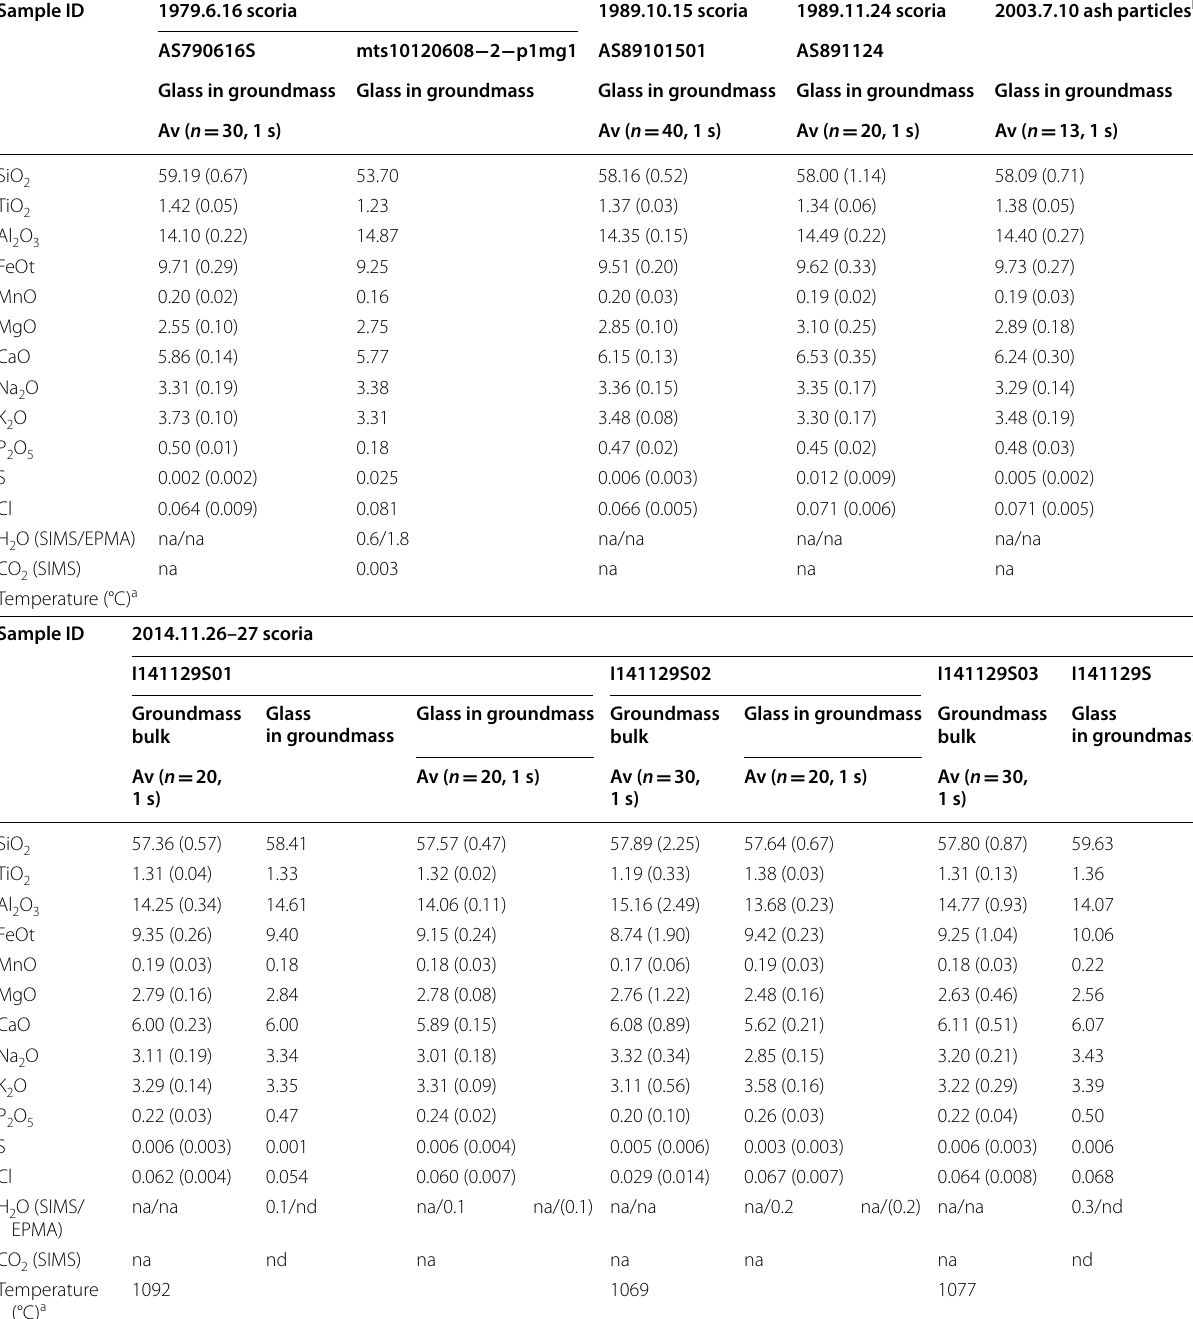
Table 4 Chemical composition of glass in groundmass and groundmass bulk in the scoria and the ash particles from the 1979, 1989, 2003, and 2014 eruptions